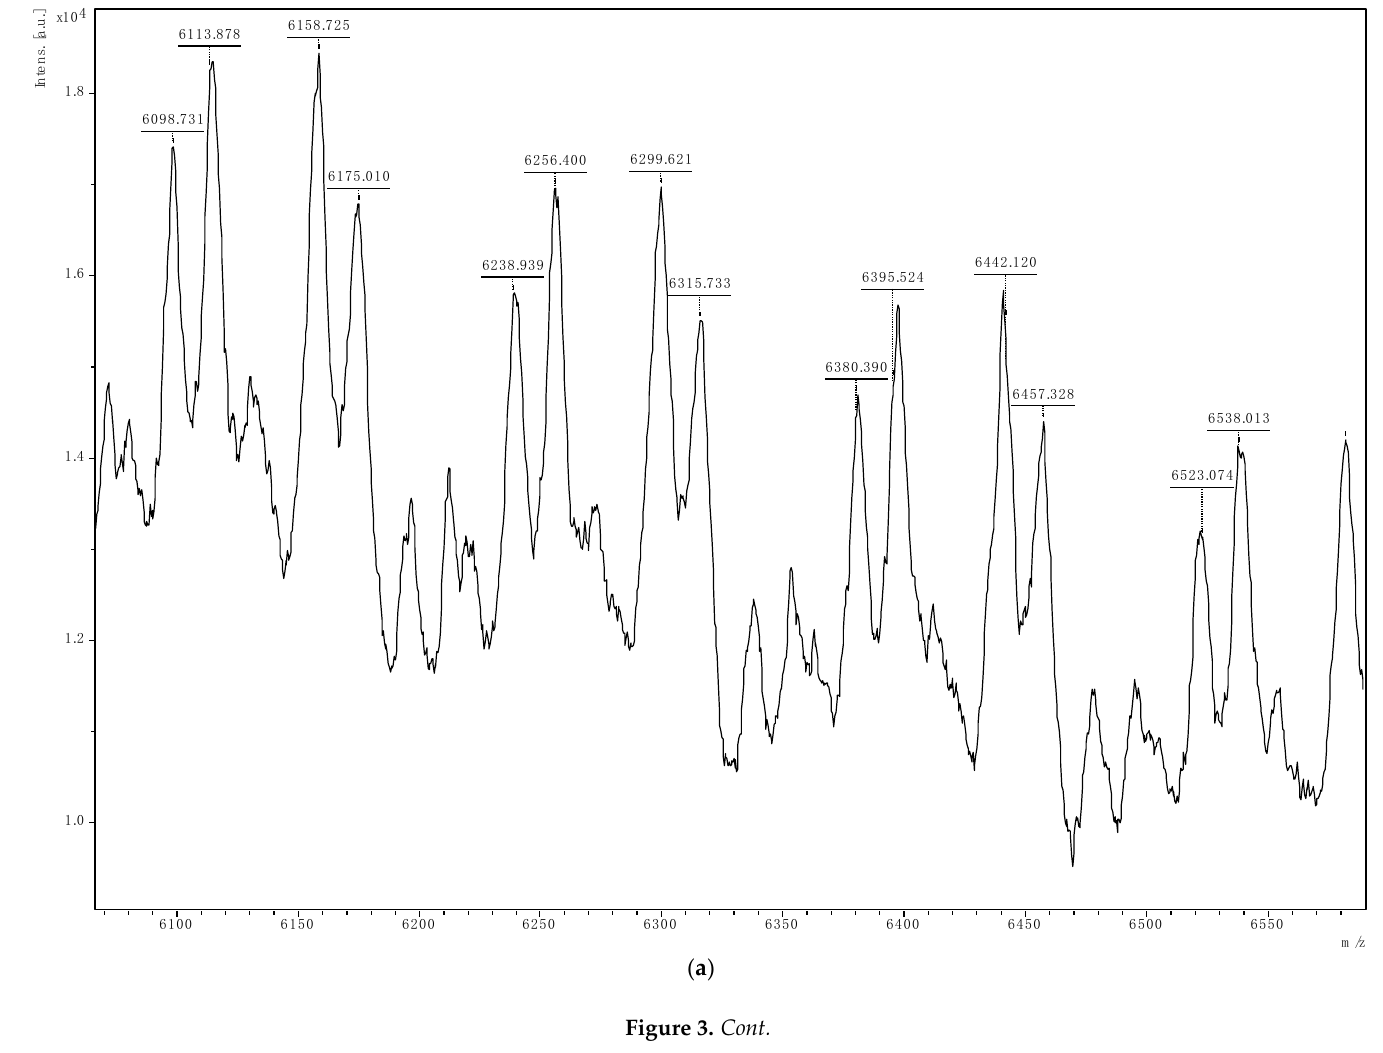
Figure 3. Cont. Figure 3.